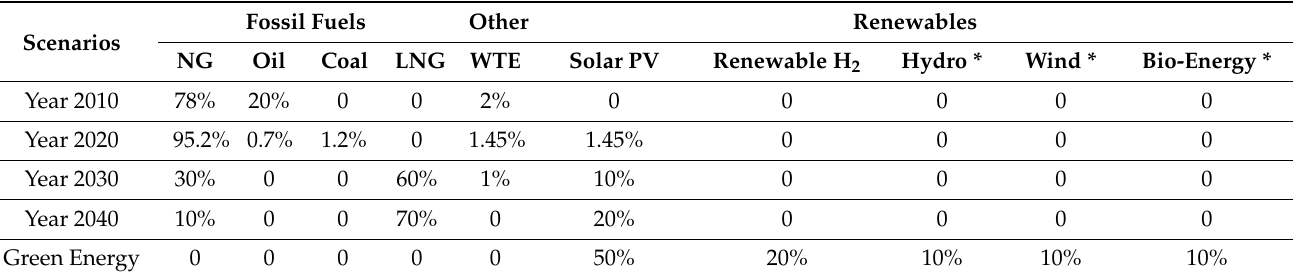
Table 1. Projected Scenarios.